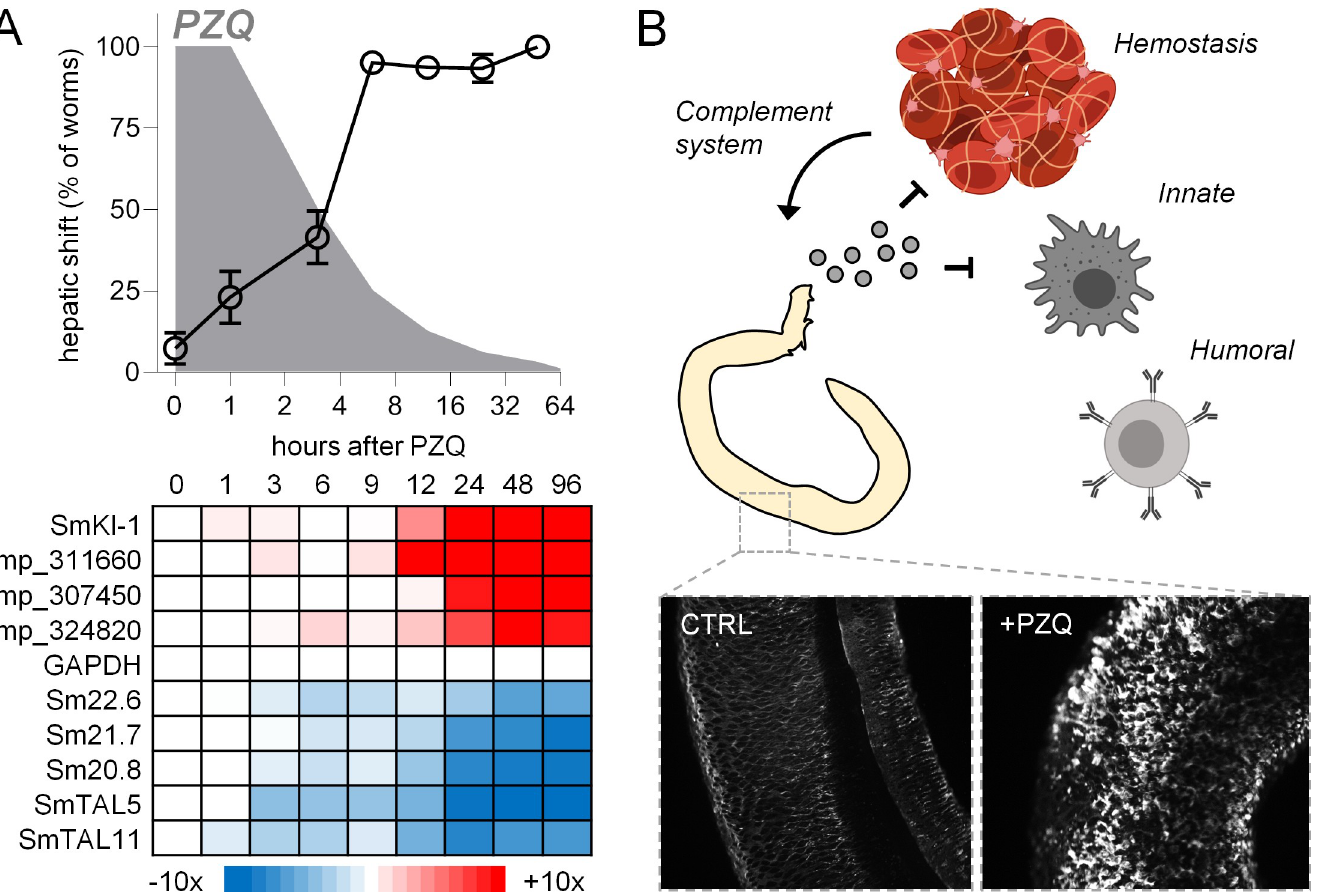
Fig 5. PZQ-evoked changes in immunomodulatory gene products corresponds to the onset of the parasite hepatic shift. (A) Top— Kinetics of parasite hepatic shift following PZQ (open symbols, data from Fig 1B) and predicted PZQ elimination in a murine model (grey, data based on refence [28]). Bottom— Expression (fold change) of various immunomodulatory gene products such as Kunitz-type protease inhibitors (increasing, red) and tegument-like allergens (decreasing, blue) in worms harvested at various points in the PZQ time-course (data from S1 File). (B) Possible model for schistosome release of immunomodulatory signals in response to chemotherapy. Worms normally reside within the host circulatory system, evading detection by the innate and humoral immune system. The parasite tegument is damaged following PZQ exposure, and worms are exposed to the milieu of immune cells within the liver. Secreted signals may dampen the immune response, as well as impair coagulation and resulting activation of the complement pathway. Images created with BioRender.com.